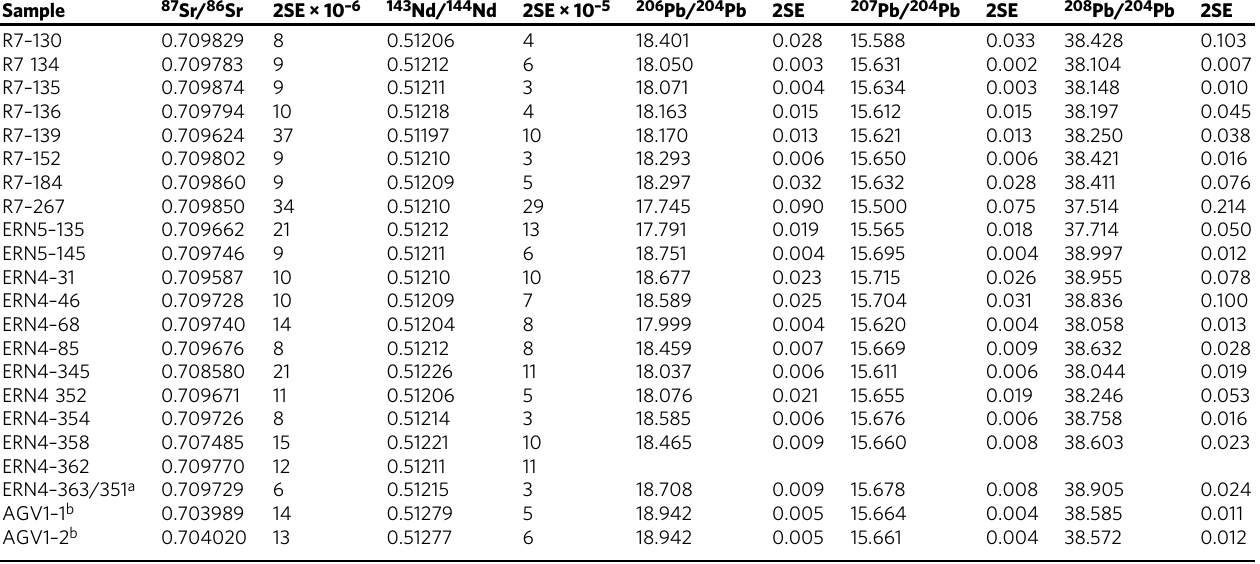
Table 1 Sr-Nd-Pb isotope compositions of Roccamon fi na – Ernici melt inclusions Sample 87 Sr/ 86